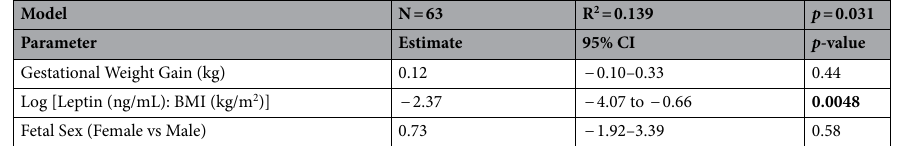
Table 4. Final generalized linear model assessing the effect of log leptin:BMI ratio and potentially confounding variables on length of gestation after stepwise backward selection. Significant values are in bold.